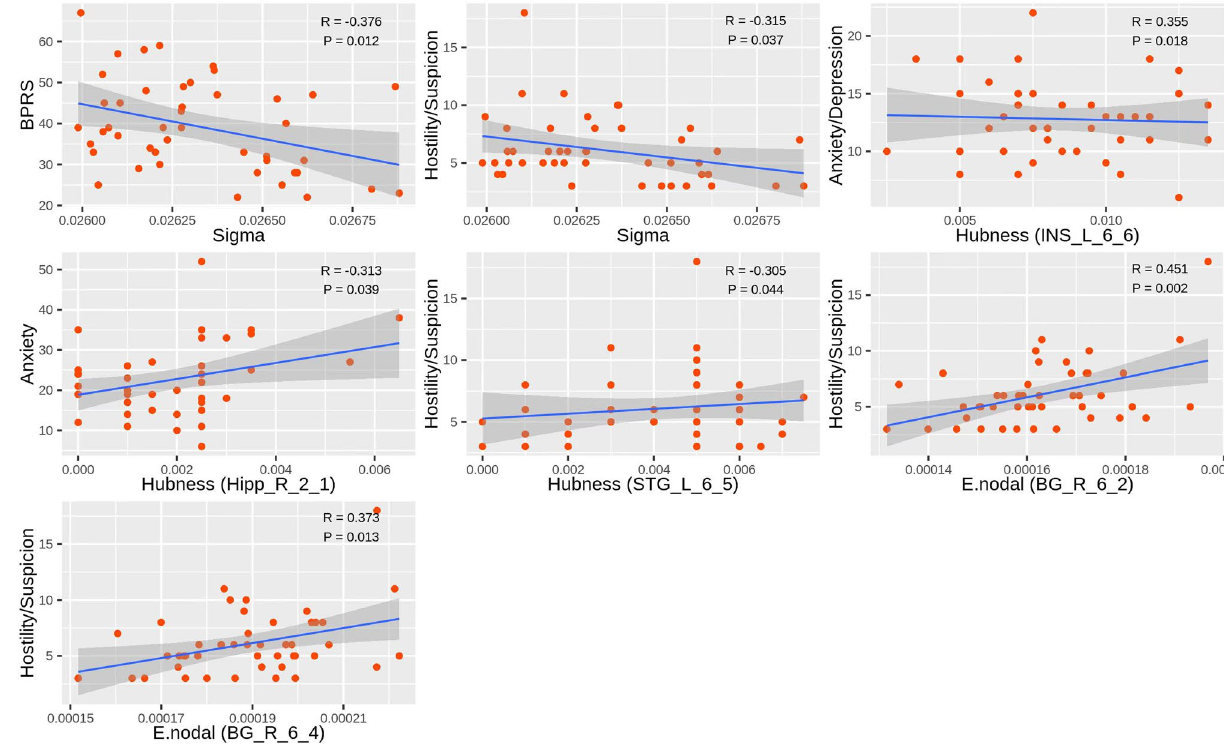
Figure 4. The correlation between weighted topological attributes and HAMA scores or Brief Psychiatric Rating Scale (BPRS) (total scores or factor scores) in methamphetamine-dependent patients. Sigma = small- worldness scalar; INS_L_6_6 = the hubness scores of the left dorsal dysgranular insula; Hipp_R_2_1 = the hubness scores of the rostral hippocampus; STG_L_6_5 = the hubness scores of the left superior temporal gyrus caudal area; BG_R_6_2 = the weighted nodal efficiency of the globus pallidus; BG_R_6_4 = the weighted nodal efficiency of the ventromedial putamen. Topological attributes Weights Hubness (left superior parietal lobule caudal area) 0.215 Hubness (right precentral gyrus head and face region) 0.273 Hubness (right caudal lingual gyrus) 0.329 0.0498 0.136